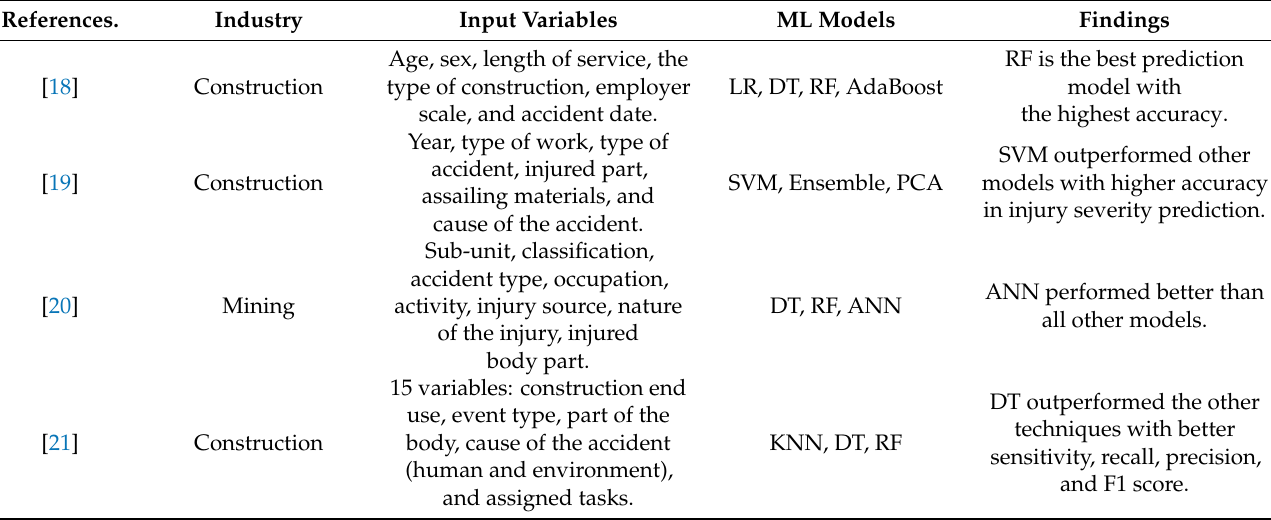
Table 1. Summary of ML Models of Occupational Injury Prediction in Existing